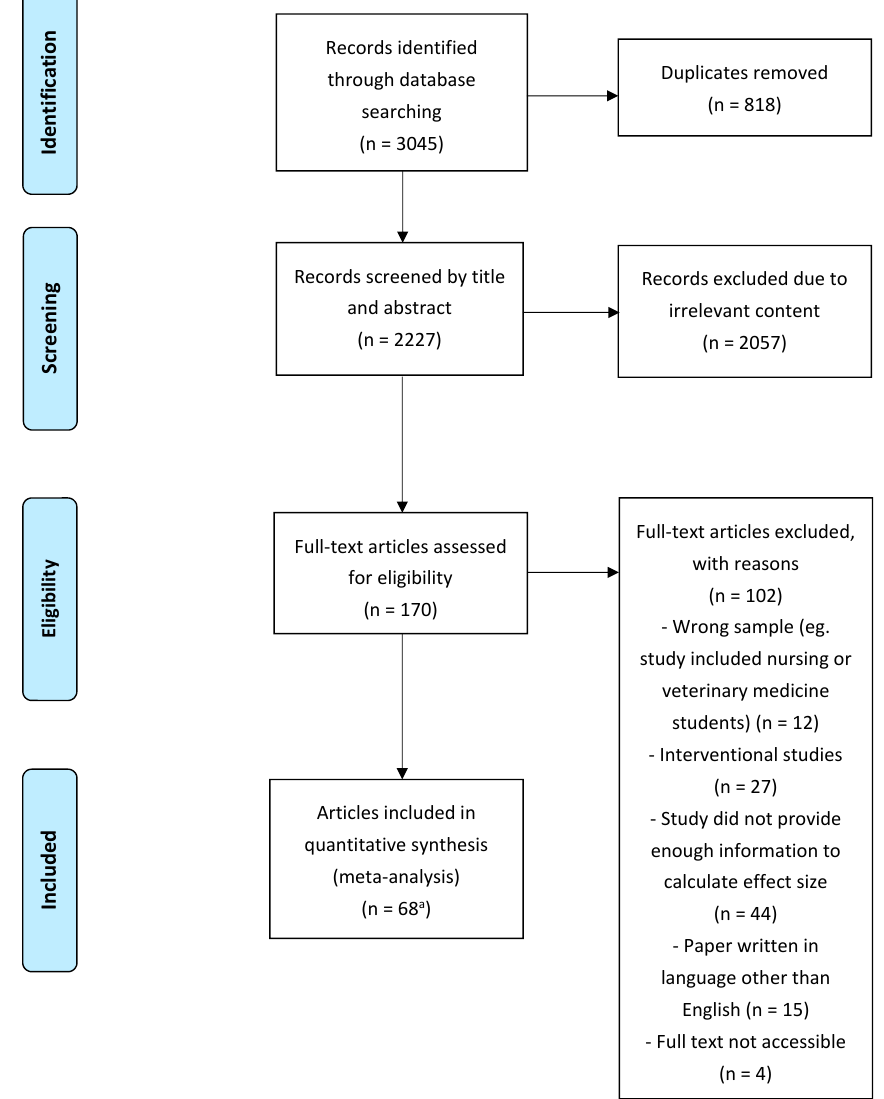
Figure 1. Preferred Reporting Items for Systematic Reviews and Meta-Analyses (PRISMA) flow diagram illustrating the search and selection process of a March 2019 systematic review of the literature on prevalence of anxiety among medical students. a One article (El-Gilany, 2008) reported two